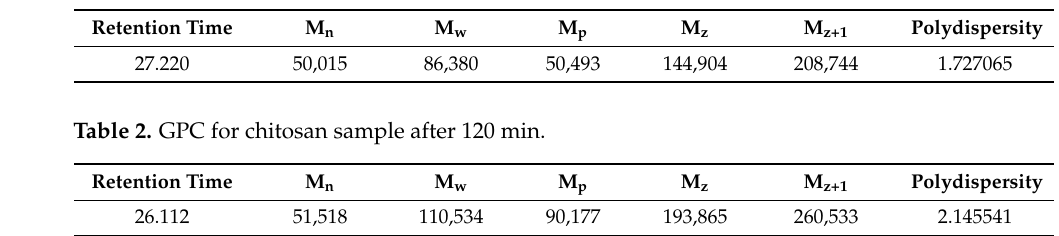
Figure 6. Thermogravimetric analysis (TGA) for chitosan and composite.